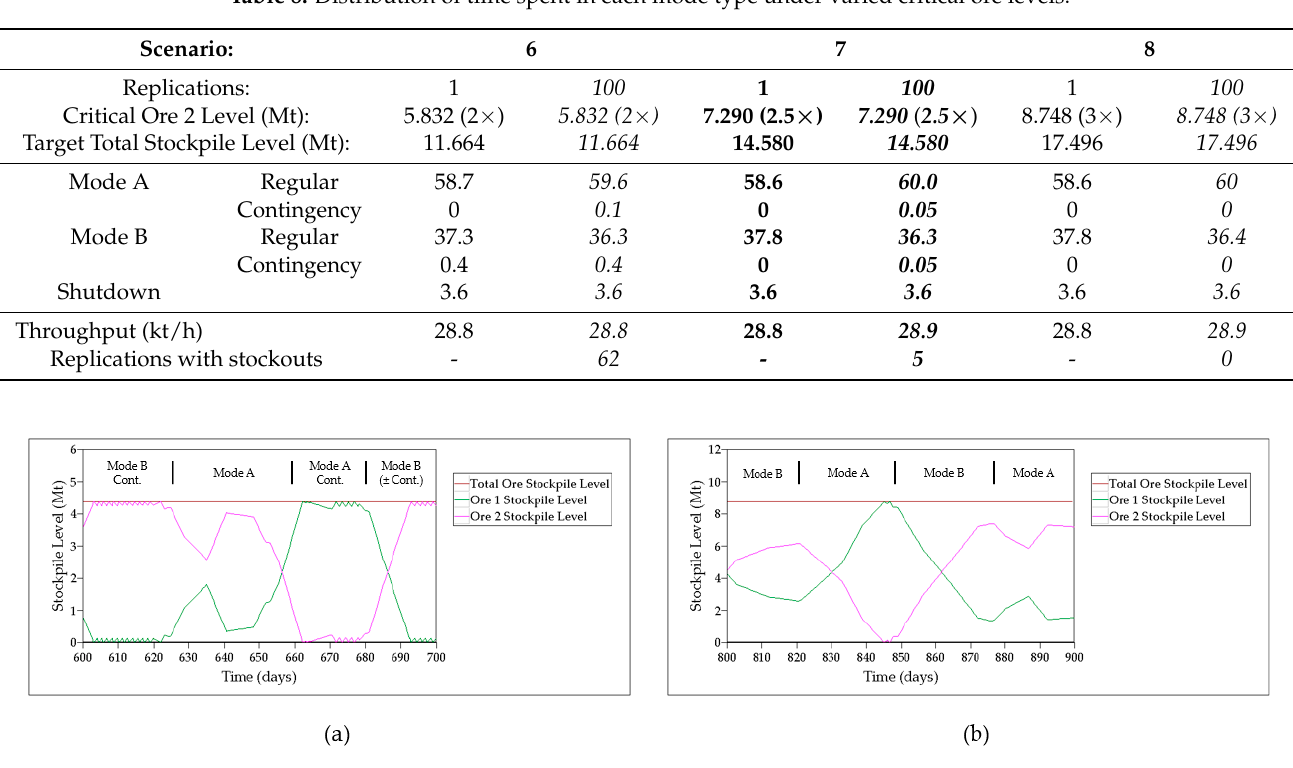
Table 7. Distribution of time spent in each mode type under varied target total stockpile levels.